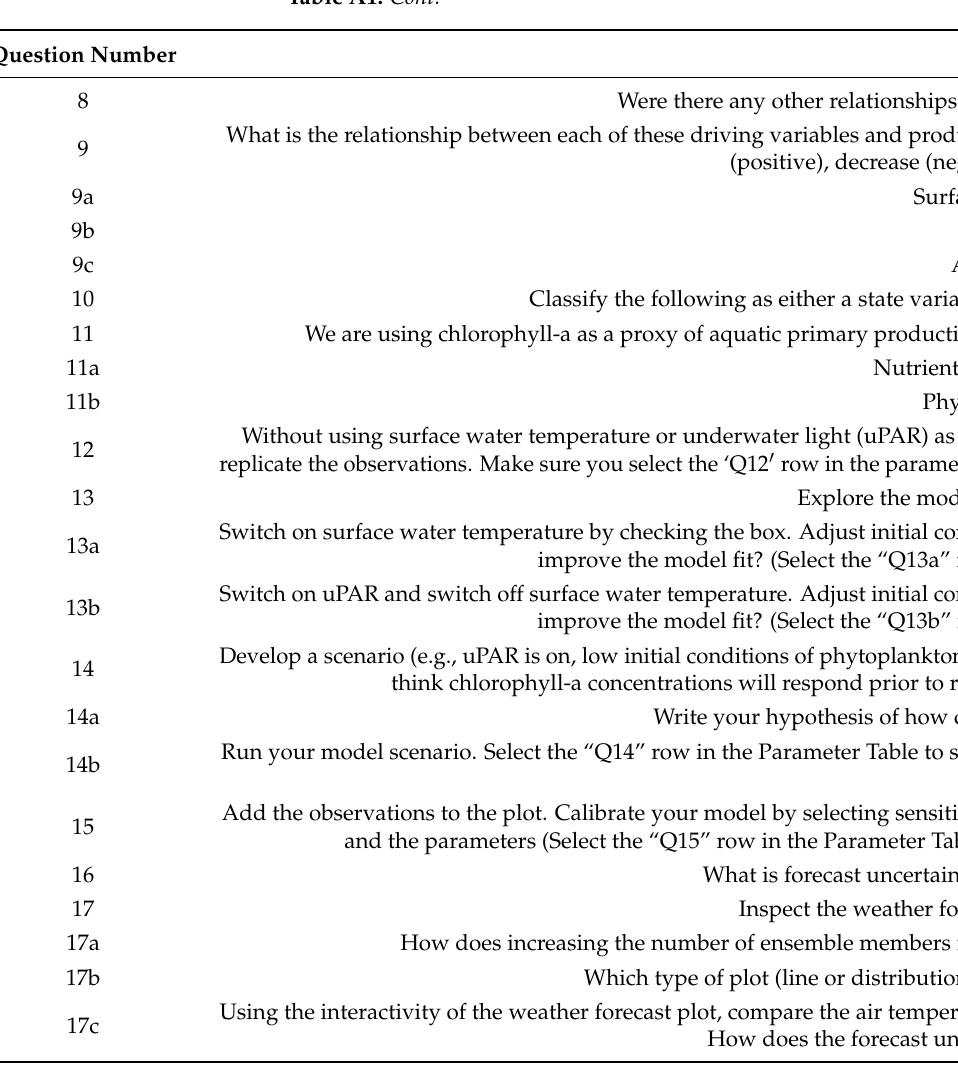
Were there any other relationships you found at your site? If so, please describe below. What is the relationship between each of these driving variables and productivity? For example, if the driving variable increases, will it cause productivity to increase (positive), decrease (negative), or have no effect (stay the same).